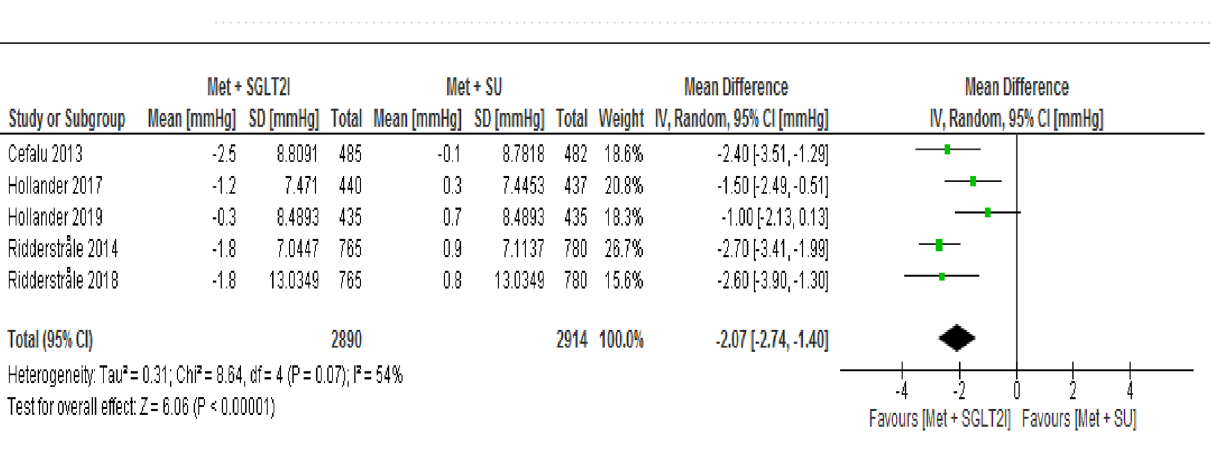
Figure 4. Comparison of changes in systolic blood pressure between patients who were on metformin-SGIT2I and metformin-sulphonylureas combination therapies. CI confidence interval; df degree of freedom; MD mean difference; Met metformin; SGLT2I sodium-glucose co-transporter 2 inhibitor; SU sulfonylurea; SD standard deviation.